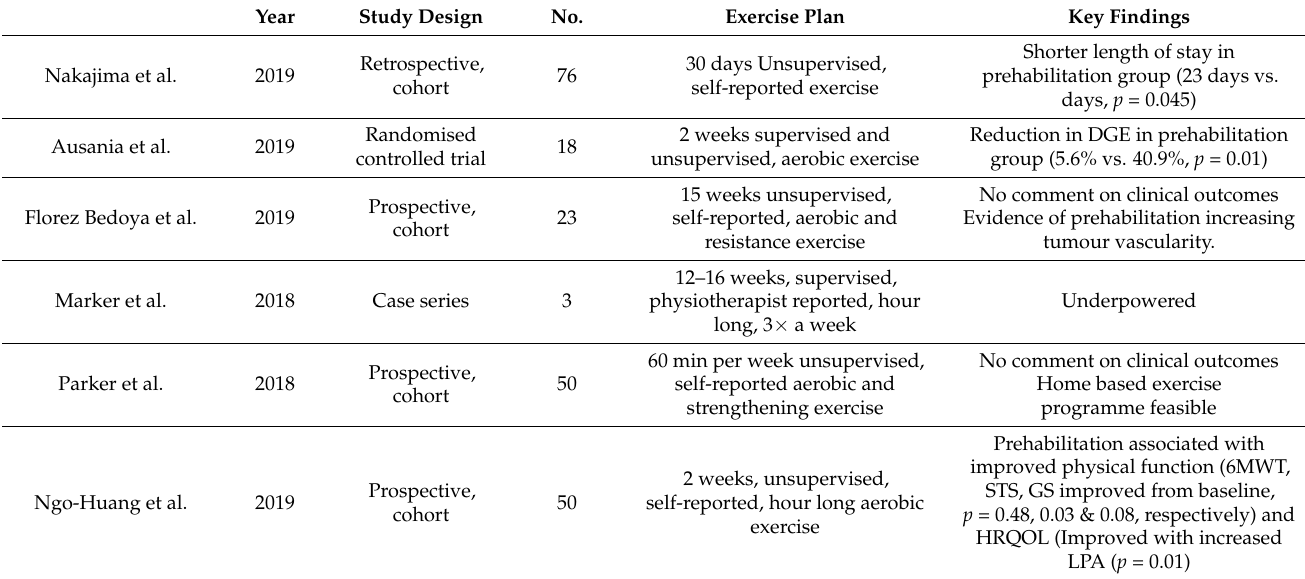
Table 3. Summary of prehabilitation studies for pancreatic resection.